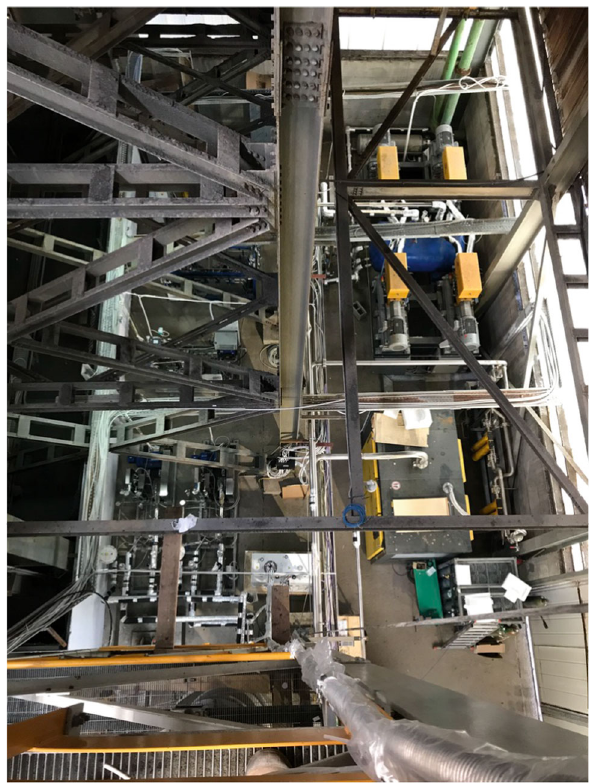
Fig. 11 Aerial view of the prototype Aria plant located in the Laveria building of the Carbosulcis mine, Nuraxi-Figus site. From bottom left, clockwise, the liquid pumps, the cryocoolers, and the gas compressor